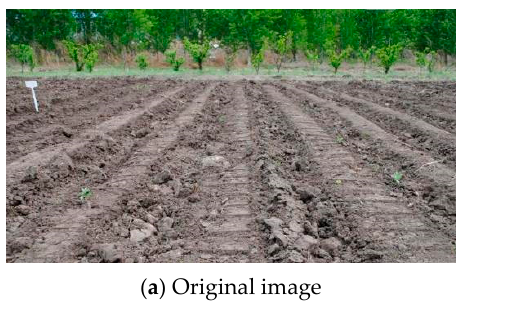
Figure 2. Original images and target images for scale test.